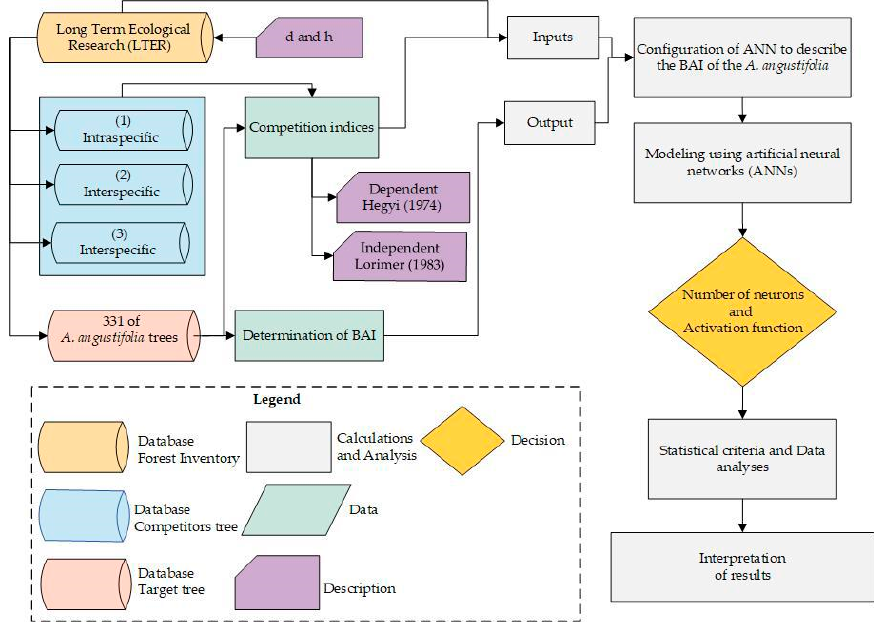
Figure 2. Flowchart of the workflow steps adopted in this study.